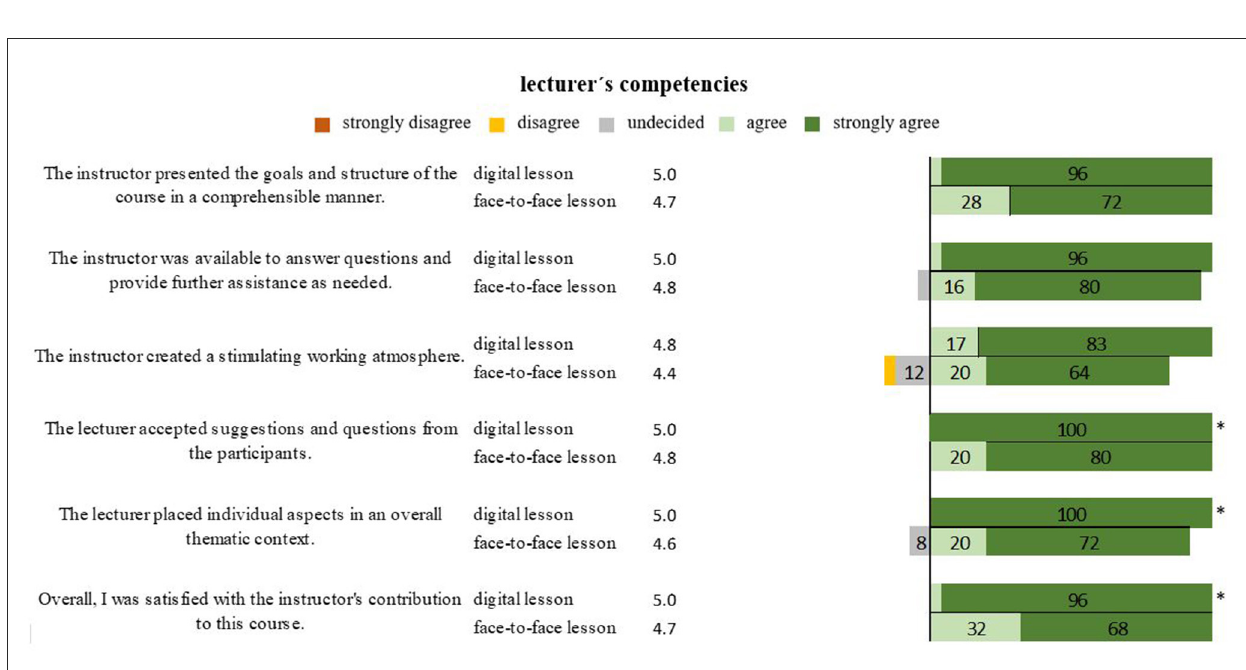
FIGURE3 Representation of students’ opinions of lecturers in digital and face-to-face teaching in percentages. *Marks significant differences.